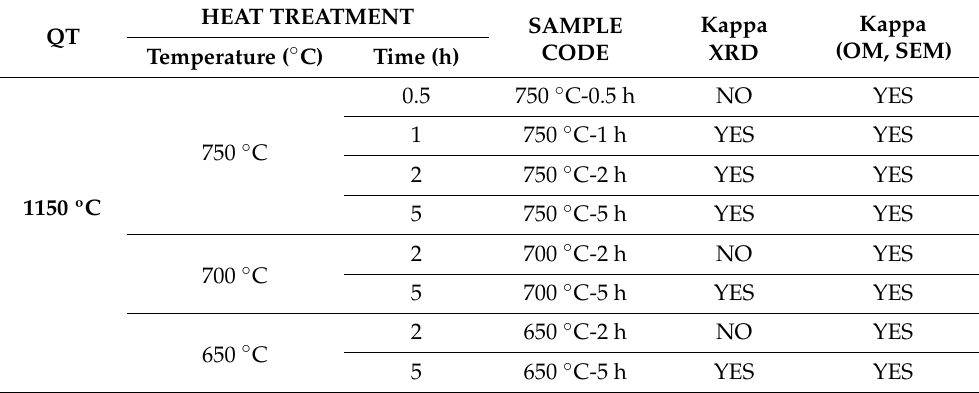
Table 1. Applied isothermal heat treatments and results from the detection of Kappa carbides using XRD, Optical Microscope and